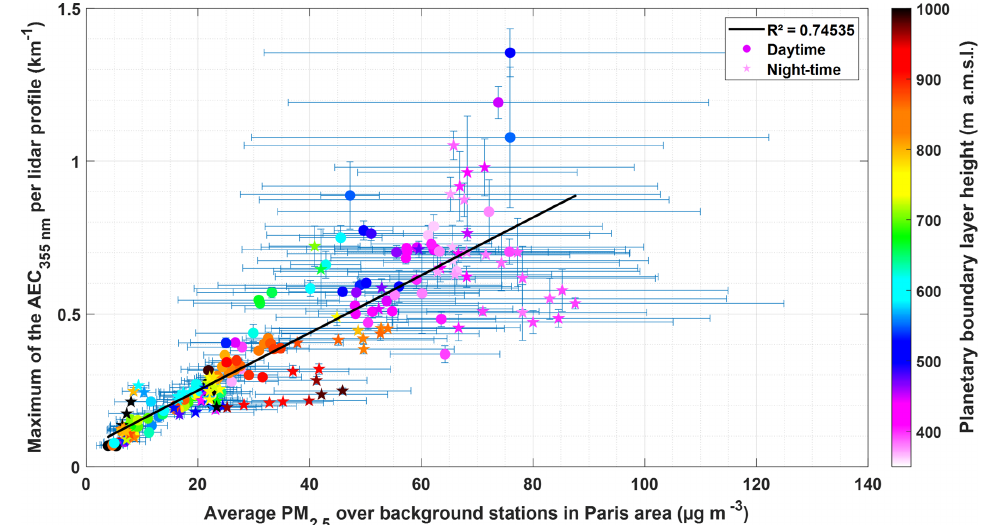
Figure 13. As in Fig. 11 but replacing AOT lid with the maximum value of the AEC profile retrieved by the LAASURS within the